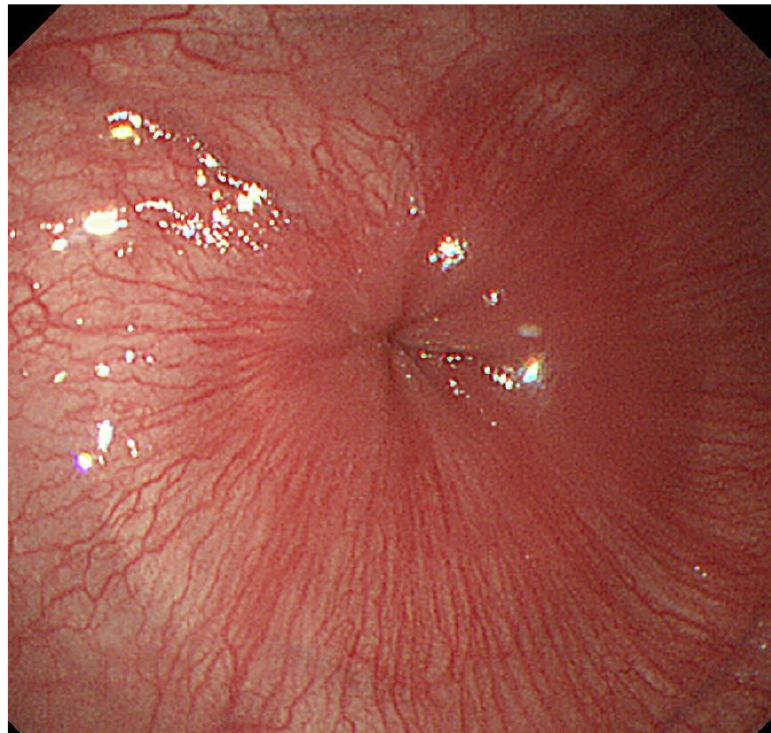
Figure 2. A case in which Gingko leaf sign was observed. Gingko leaf-shaped morphology was observed at the esophago-gastric junction during the end of deep inspiration.